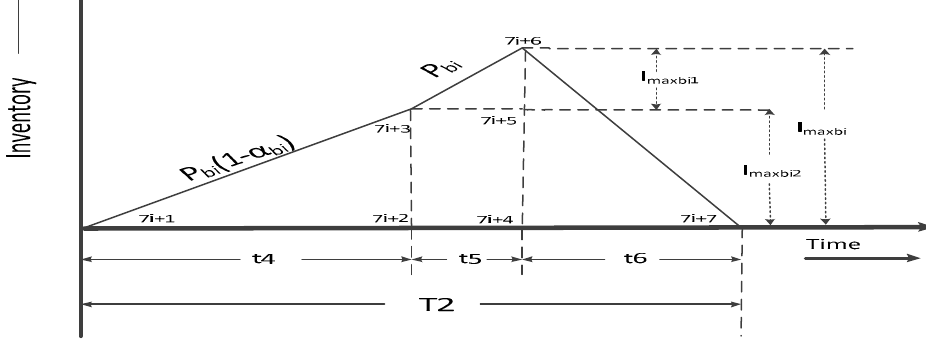
Figure A5. General form for inventory diagram of the ith outsourcer .